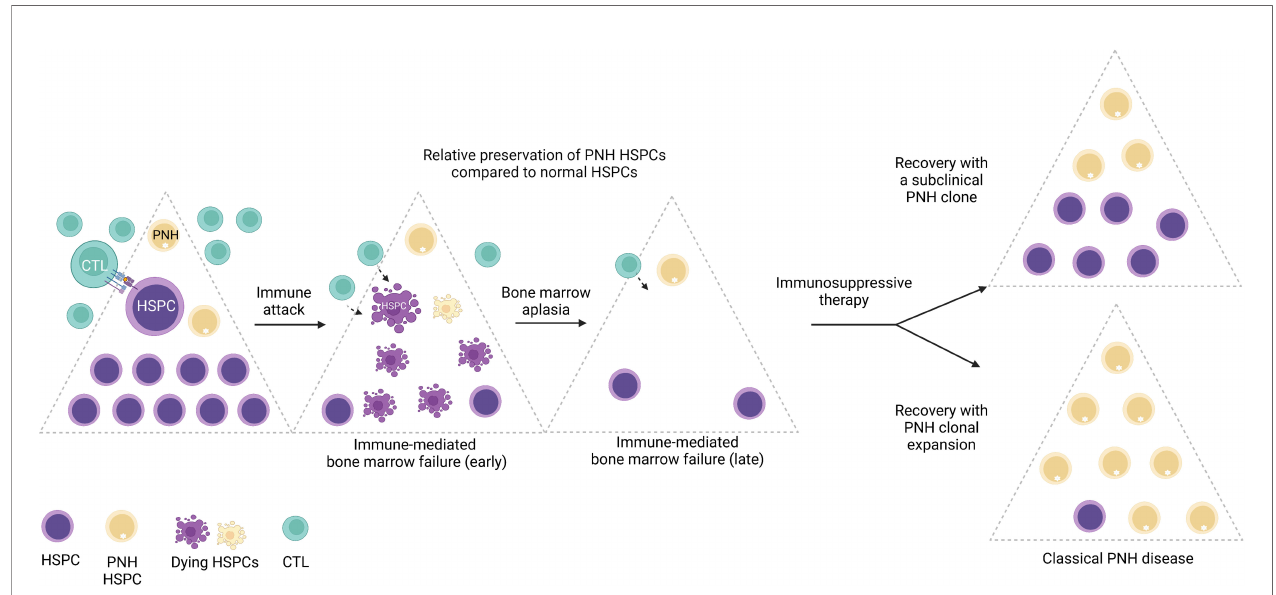
FIGURE 3 | The emergence of PNH clones is closely related to immune-mediated bone marrow failure. A schematic diagram illustrating the relationship between immune-mediated bone marrow failure (acquired aplastic anemia) and clonal expansion of HSPCs with somatic mutations in the PIGA gene (PNH HSPCs). In acquired aplastic anemia, cytotoxic T lymphocytes (CTL) recognize an unknown autoantigen presented by the hematopoietic stem and progenitor cells (HSPCs). Aberrant recognition of the HSPCs leads to their autoimmune destruction (shown as dying HSPCs) and manifests clinically as bone marrow failure. PNH HSPCs are hypothesized to have relative resistance to autoimmune destruction in AA. In AA patients treated with immunosuppressive therapy, bone marrow may recover with a smaller subclinical PNH clone; however, in a subset of patients, PNH HSPCs undergo progressive clonal expansion, leading to classical PNH disease, characterized by hemolytic anemia and related symptoms, and an increased risk of thrombosis. Figure created with